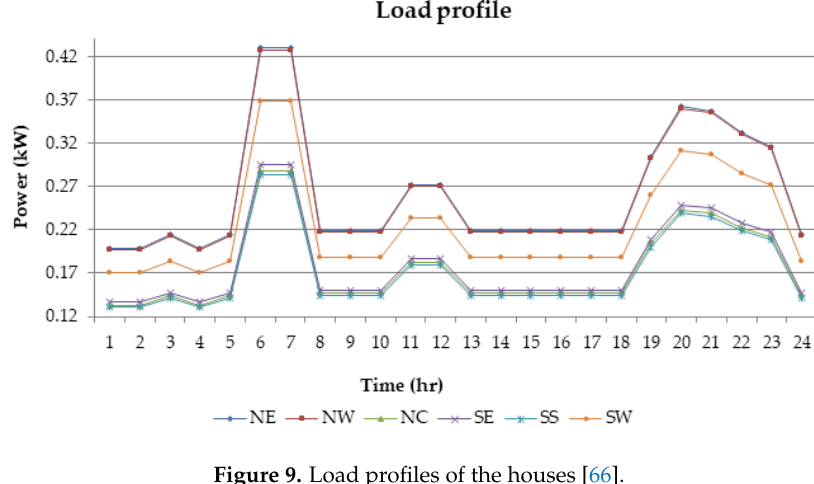
Figure 9. Load profiles of the houses